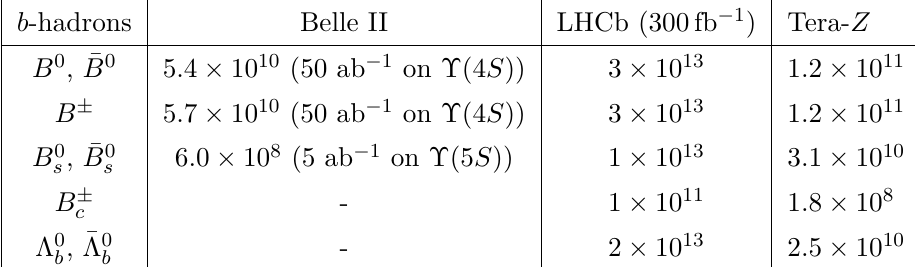
Table 1 . Expected yields of b -hadrons at Belle II, LHCb Upgrade II, and Tera- Z . The cross sections for b ¯ b productions at E (Υ(4 S )) and E (Υ(5 S )) are taken from [18]. The b -quark cm cm